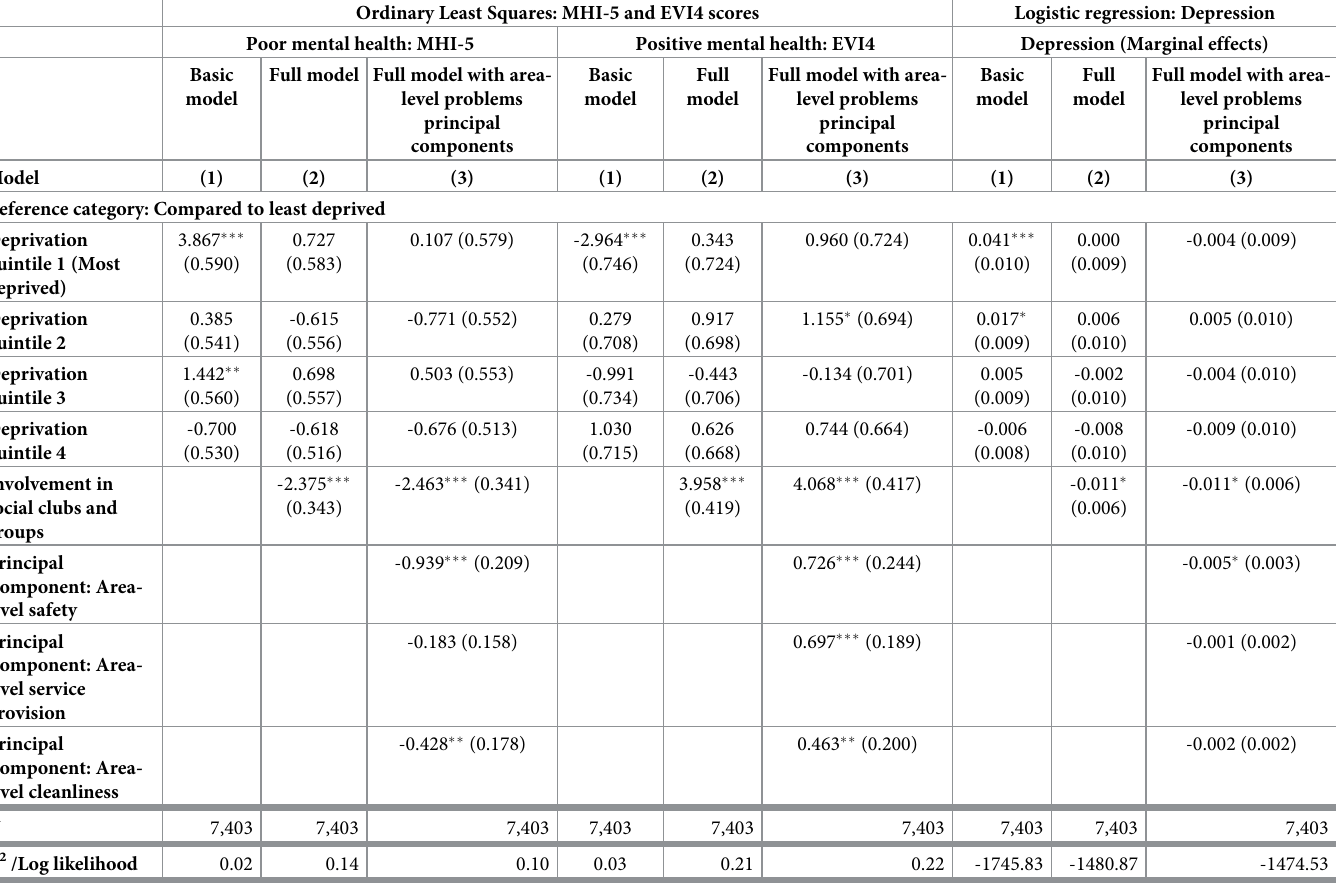
Table 5. Estimation results on three mental health